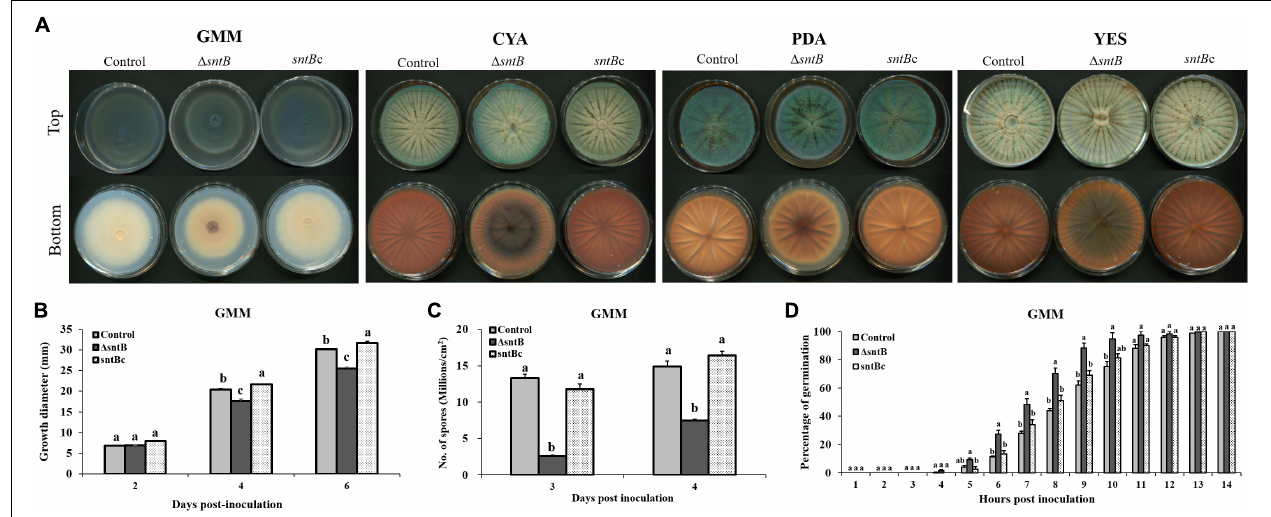
FIGURE 1 | Physiological analysis of the control, sntB deletion and complement strains of P. expansum Pe-21. (A) Growth phenotype of P. expansum strains monitored on four different media (GMM, Glucose Minimal Medium; CYA, Czapek Yeast Extract Agar; PDA, Potato Dextrose Agar; YES, Yeast Extract Sucrose Agar) for 72 h at 25 ◦ C. (B) Radial growth, (C) conidia production were monitored on GMM agar, and (D) germination rate of P. expansum strains was measured on GMM broth. One-way ANOVA differences were considered significant when p < 0.05. Different letters above the columns indicate statistically significant differences between the strains as determined using Tukey’s single-step multiple comparison